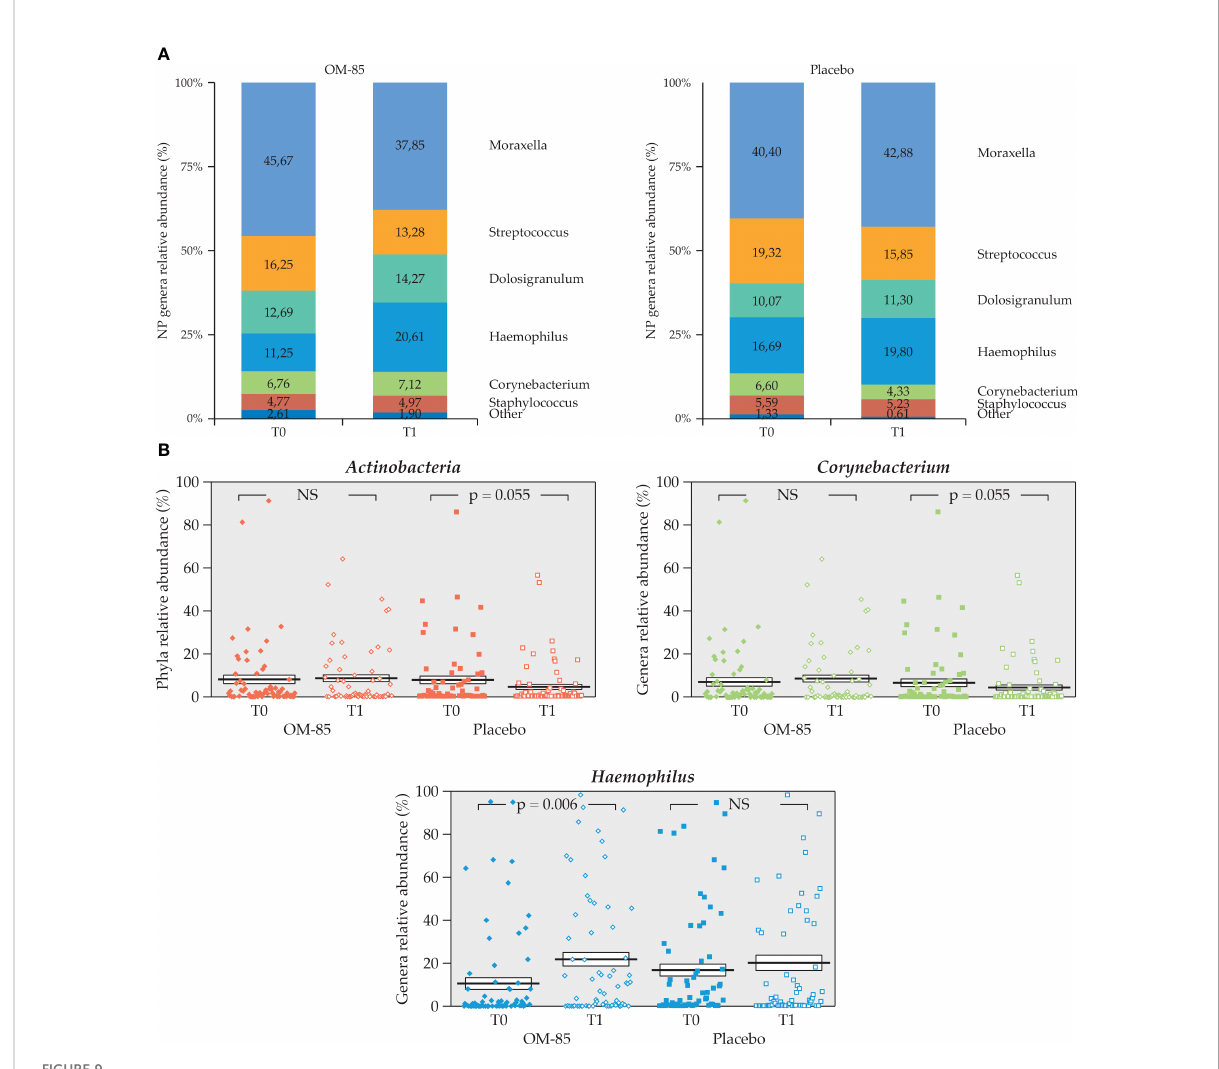
FIGURE 9 Intra – group change of NP microbiota composition in both OM – 85 and placebo groups (n=137). (A) NP microbiota pro fi les at T0 and T1 for both treatment groups (n=69, OM-85 and n=68, placebo). (B) Statistically signi fi cant intra – group difference for Actinobacteria, Corynebacterium in placebo, and Haemophilus in OM-85 (Wilcoxon ’ s signed – rank test). NS: not signi fi cant.